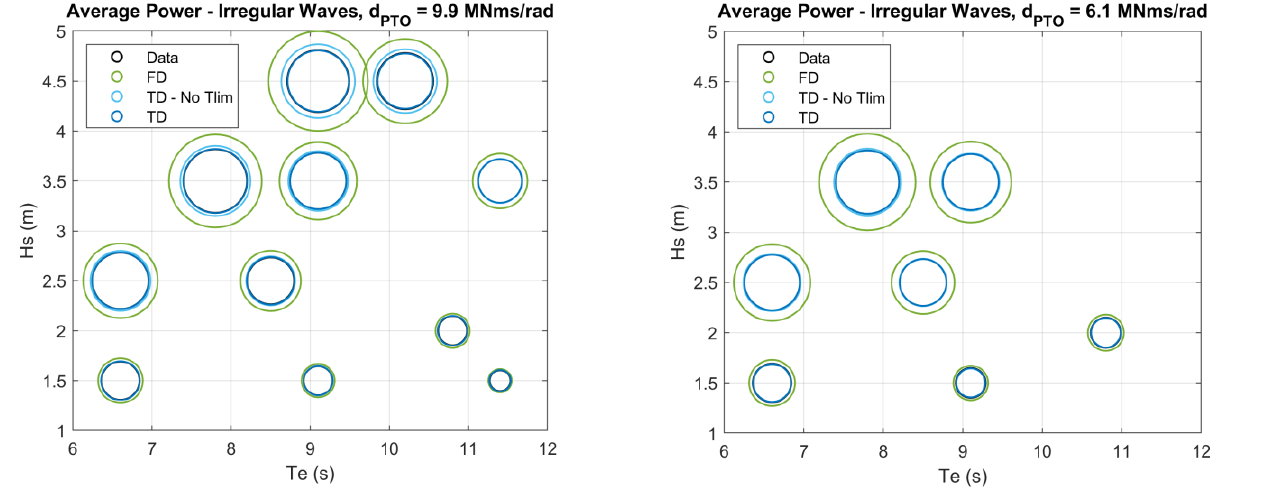
Fig. 12. Power plots Test Set 5. Hs is significant wave height. Te is energy